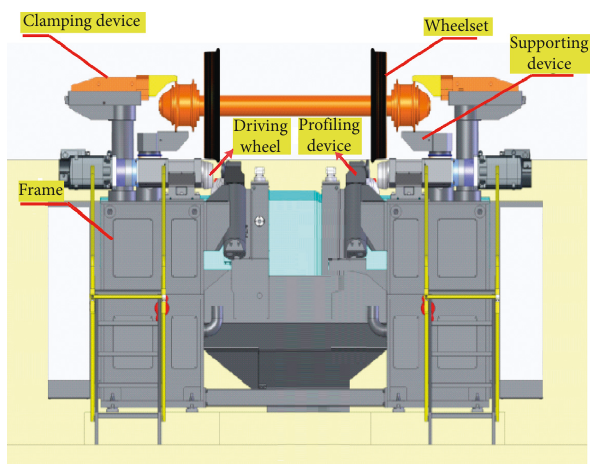
Figure 2: Underfloor wheelset lathe.